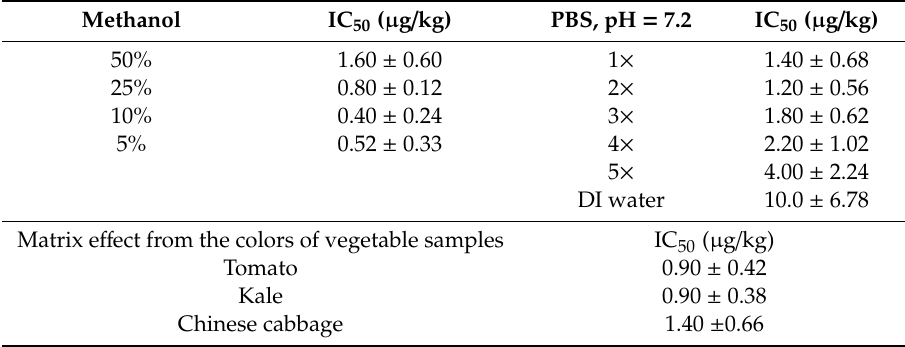
Table 1. E ff ects of the organic solvent, PBS, and matrix e ff ect from the color of vegetables on ic-ELISA.